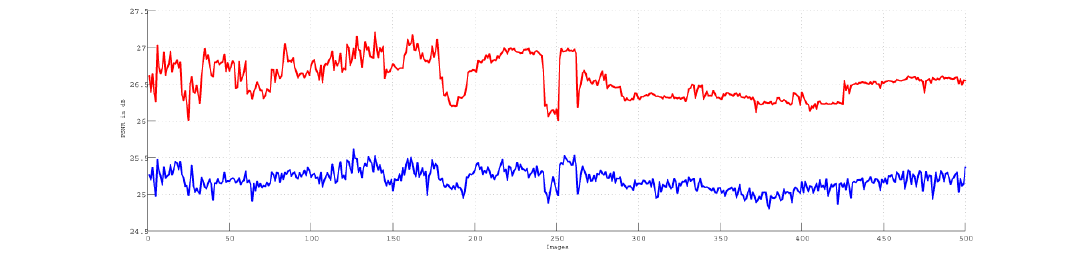
Figure 4. Peak-signal-to-noise ratio (PSNR) values for our HWF and the filtering BHPF. The red line is for the HWF and the blue line is for the BHPF. The 500 consecutive images from our training data are selected in this